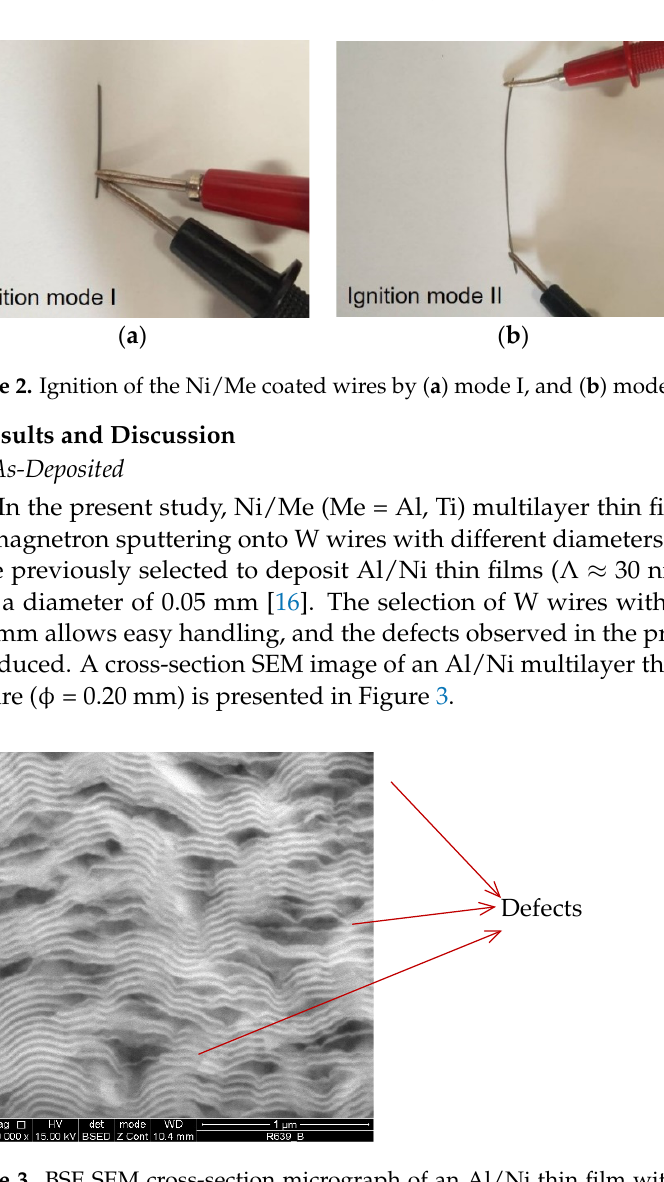
Figure 2. Ignition of the Ni/Me coated wires by ( a ) mode I, and ( b ) mode II.